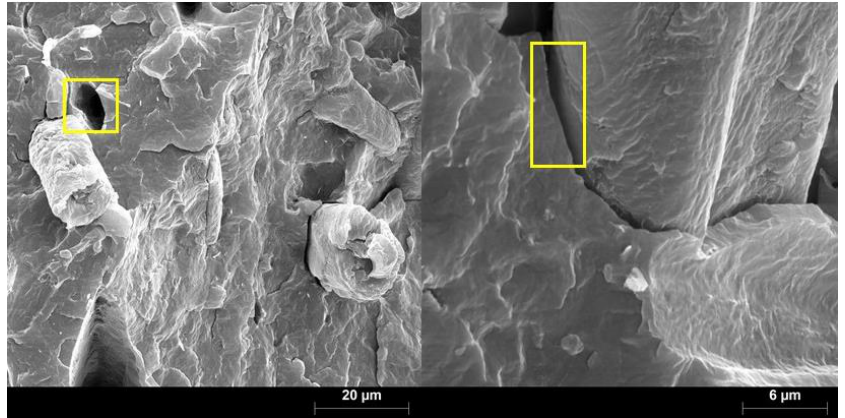
Figure 4. SEM micrographs of BiopPE reinforced with CSF.